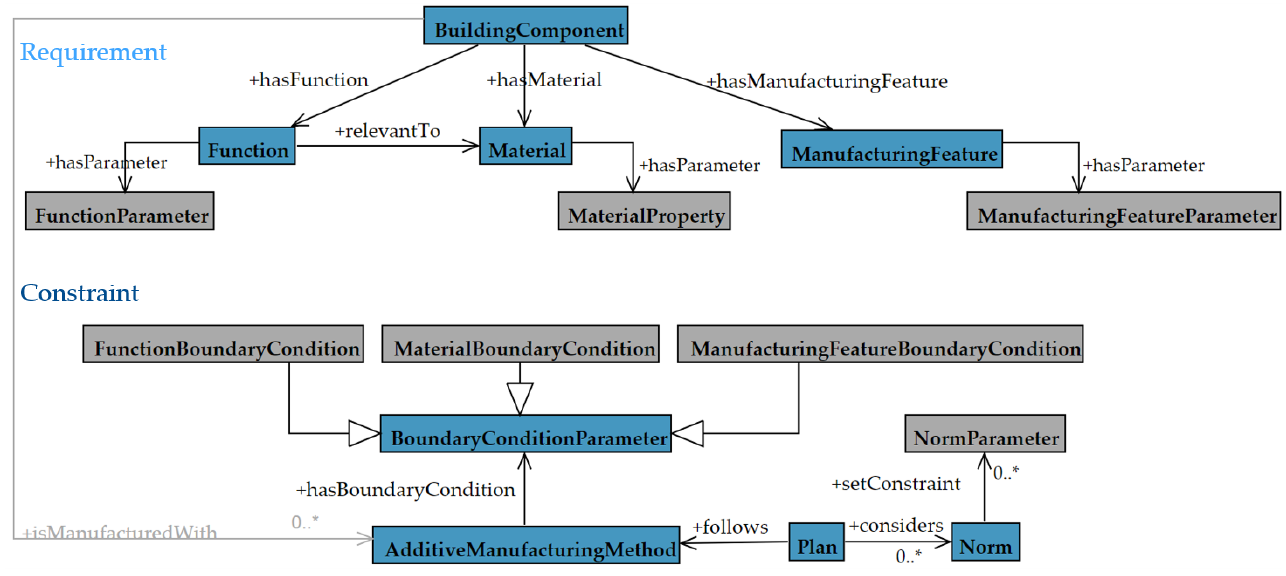
Figure 6. Requirement-constraint pattern. Unless specified, the cardinality of the associations is set to “1..*”.